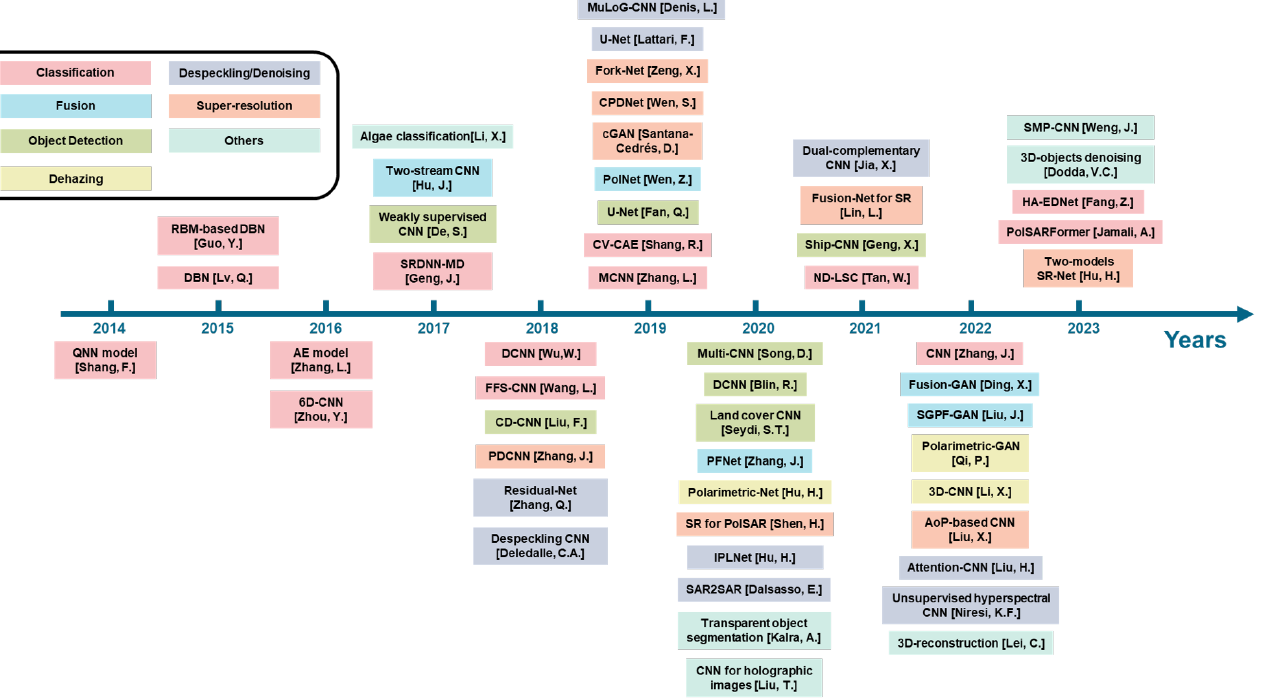
Figure 29. Chronological evolution of the reviewed works.The references mentioned here are chronologically listed as 2014 [287], 2015 [188,189], 2016 [181,291], 2017 [52,184,278,304], 2018 [92, 199,206,235,292,295], 2019 [70,91,97,140,212,221,225,234,236], 2020 [11,58,82,173–175,222,273,303,305], 2021 [226,244,282,297], 2022 [22,64,211,227,231,258,259,294,306], and 2023